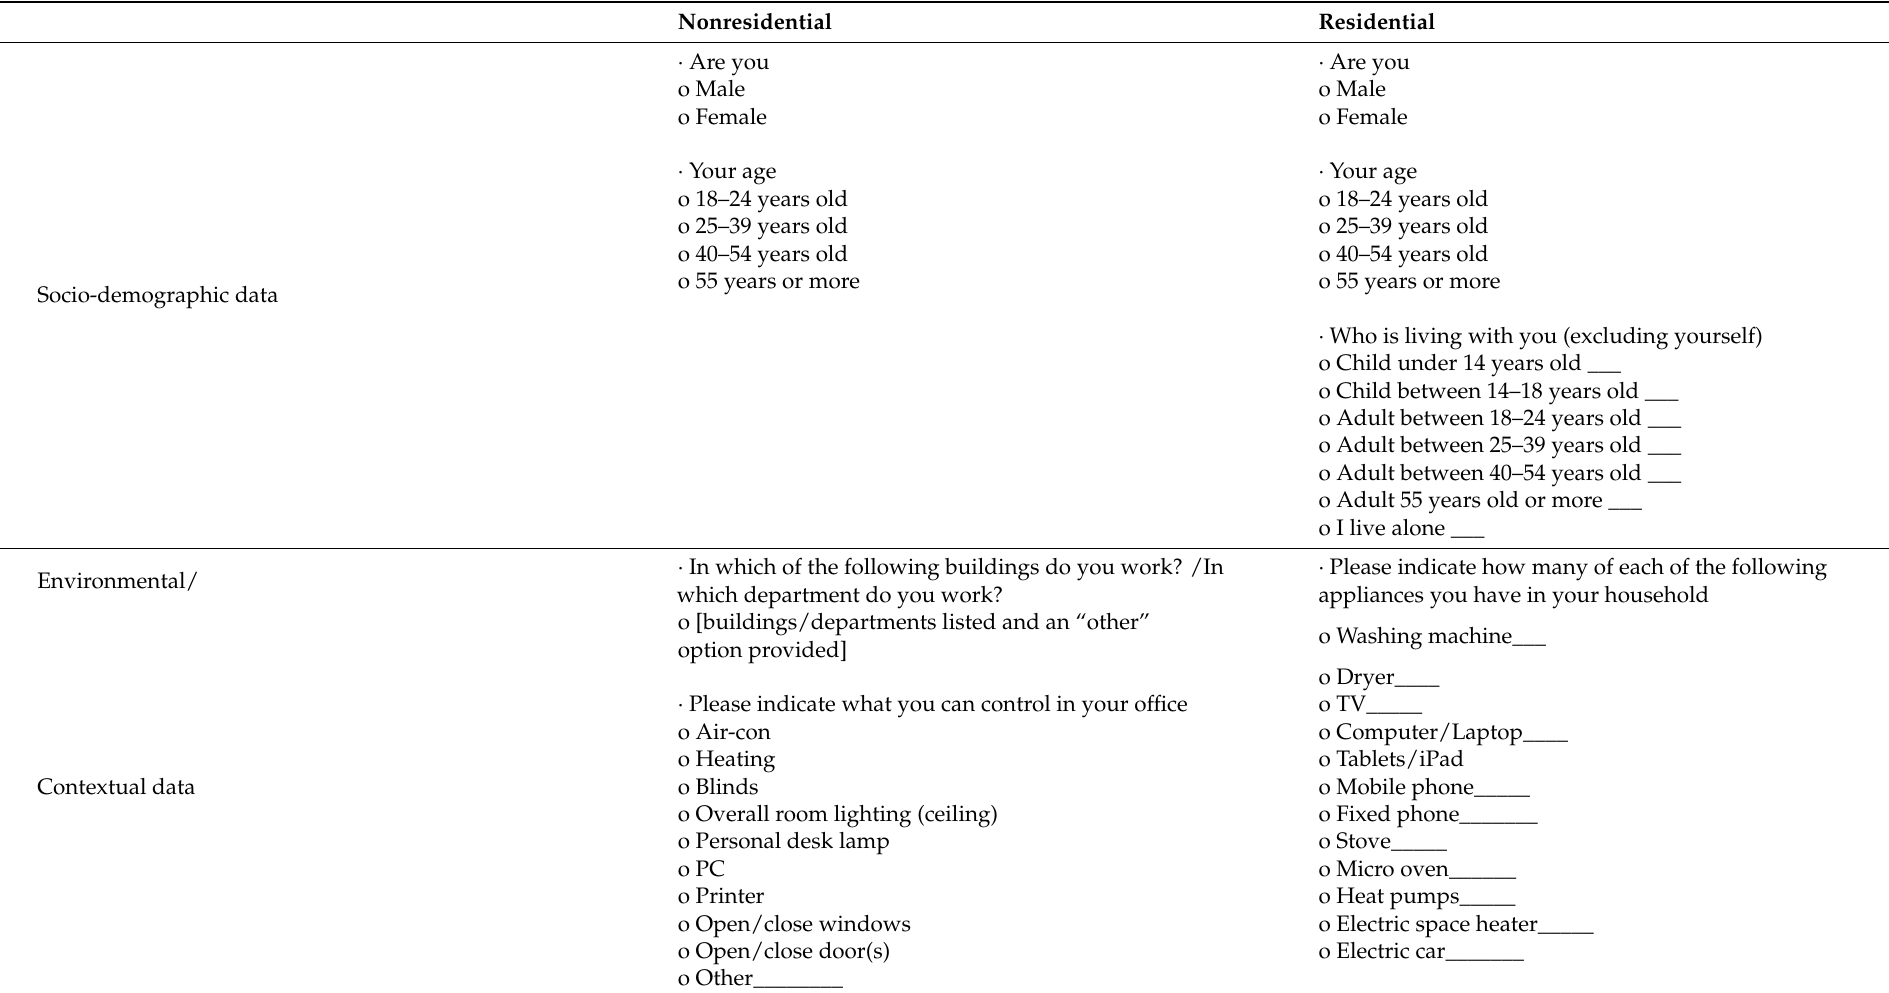
Table A2. Profile segmentation